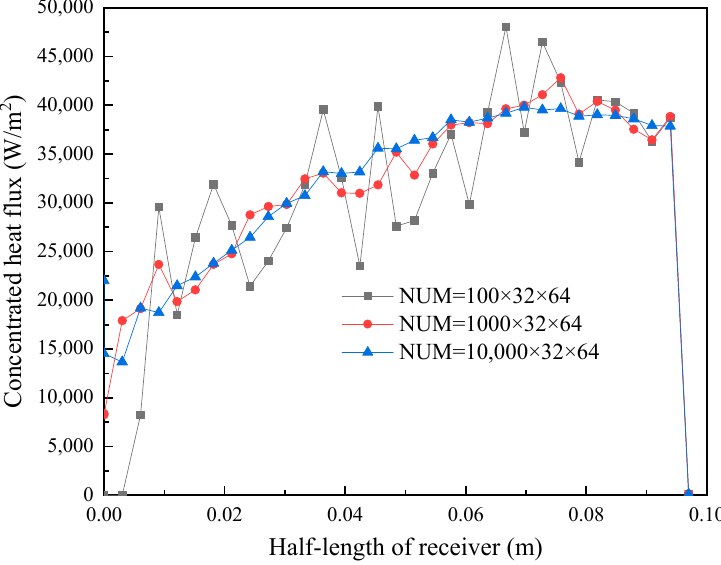
Figure 8. Simulated concentrated heat flux along the radius of the receiver.